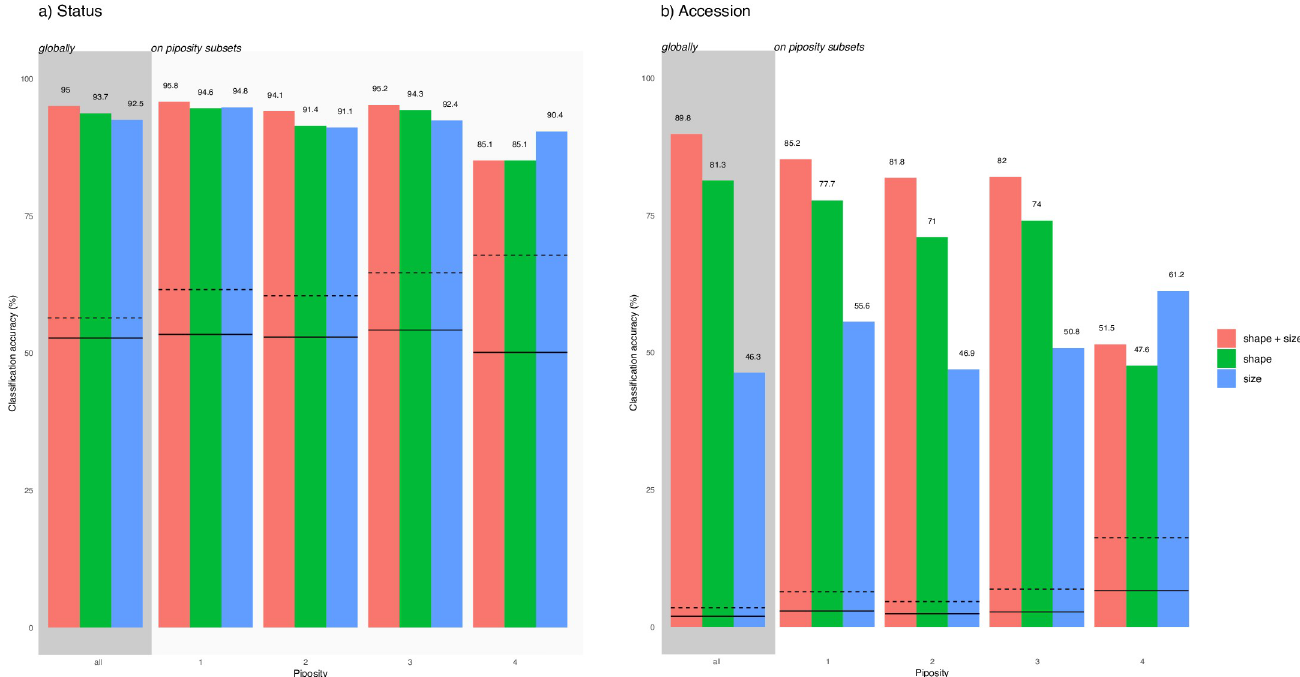
Fig 7. Classification accuracy (LDA leave-one-out) at the a) status and b) accessions levels. Models are trained (and evaluated) on the admixture of pips, then evaluated on piposity subsets. Different combinations of training data are used (Fourier coefficients of shape, lengths/mass measurements, both). Lines provide a random baseline and summarise 10000 permutations: solid line correspond to mean accuracy; dashed line to the maximal values obtained.